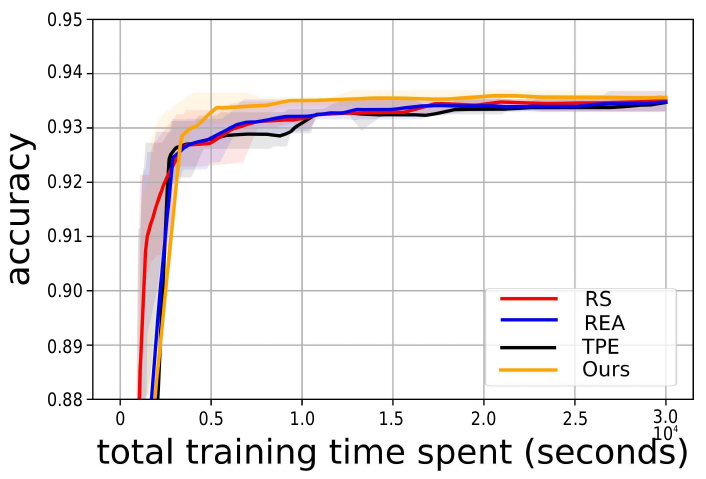
Figure 7. A comparison of the mean test regret performance of 500 independent runs as a function of estimated training time for NAS-Bench-1Shot1 on Cifar10